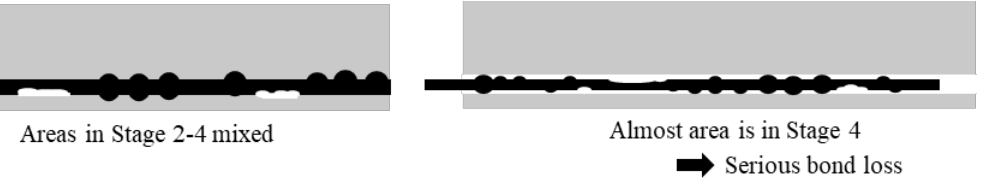
Figure 19. Interlock loss progress as an entire member with corrosion.